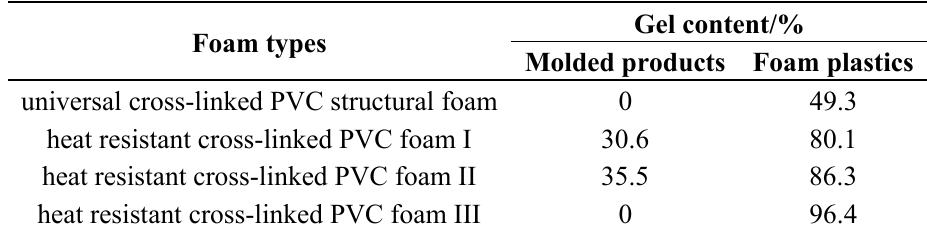
Table 1. Gel contents of molded products and foam